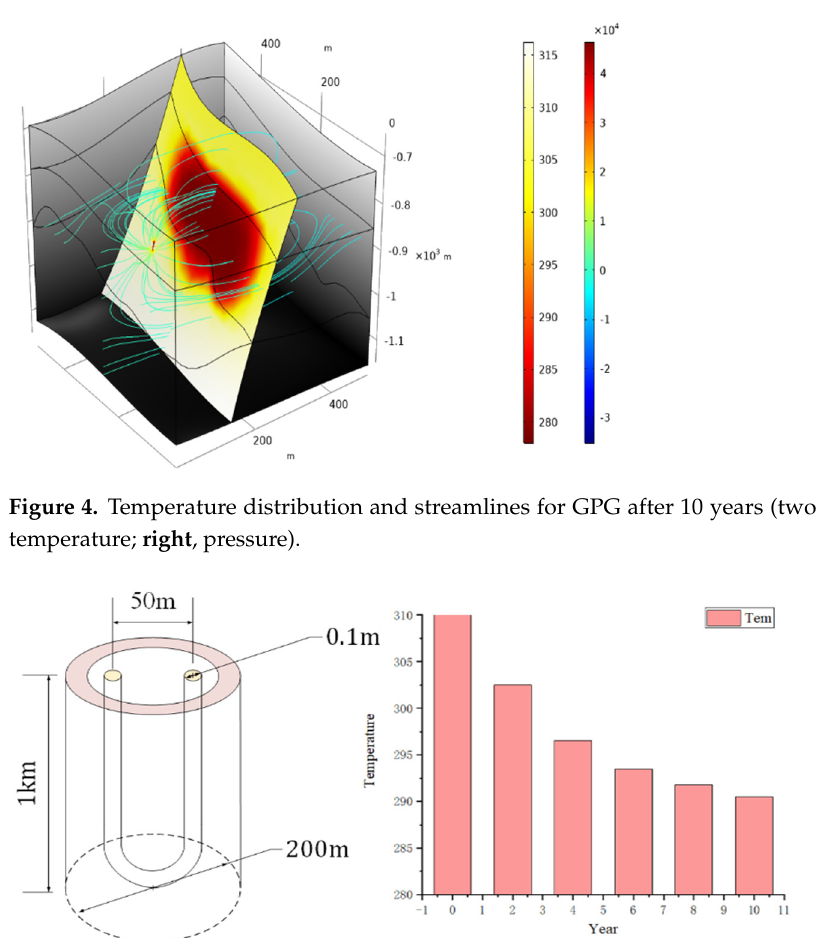
Figure 5. ( a ) Schematic diagram of the pipe in deep geothermal power generation; ( b ) variation of production temperature with fixed well distance. production temperature with fixed well